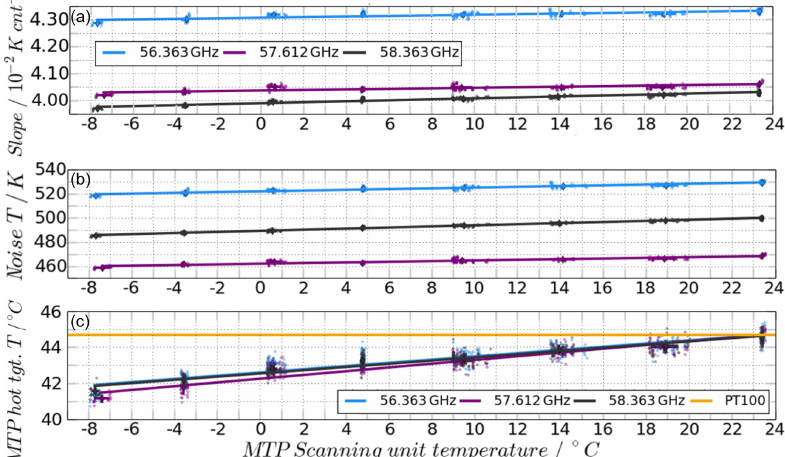
Figure 8. Calibration parameters calculated from hot–cold calibration for standard frequency channels during cold-chamber measurements. (a) Slope of calibration line. (b) Receiver noise temperature ( T R ). (c) Calculated hot target TBs at different scanning unit temperatures during cold-chamber measurements. Small dots: single measurements contributing to the average at one scanning unit temperature. Orange line: Pt100 sensor readings.